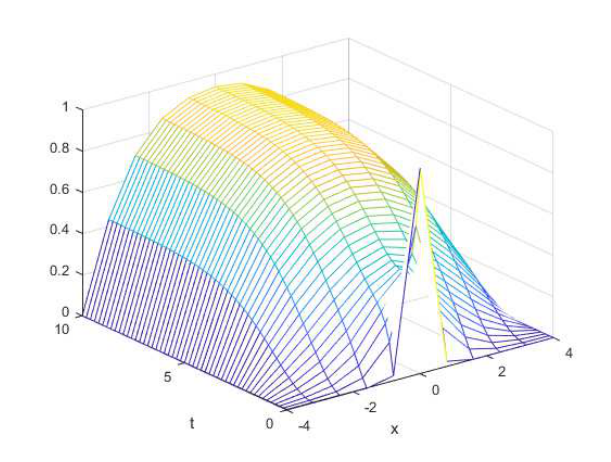
Figure 2. Approximated solution of Example 1.